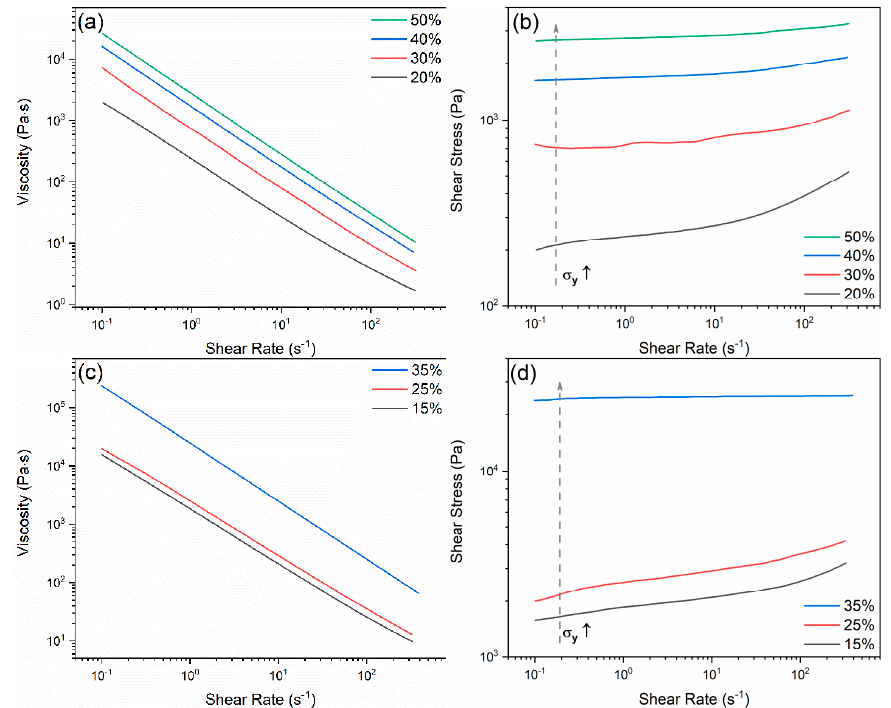
Figure 4. Flow curves and shear stress vs. shear rate curves of ( a ), ( b ) Pluronic solutions and ( c ), ( d ) glass inks of different solids loadings prepared in the 30 wt.% Pluronic stock solution.